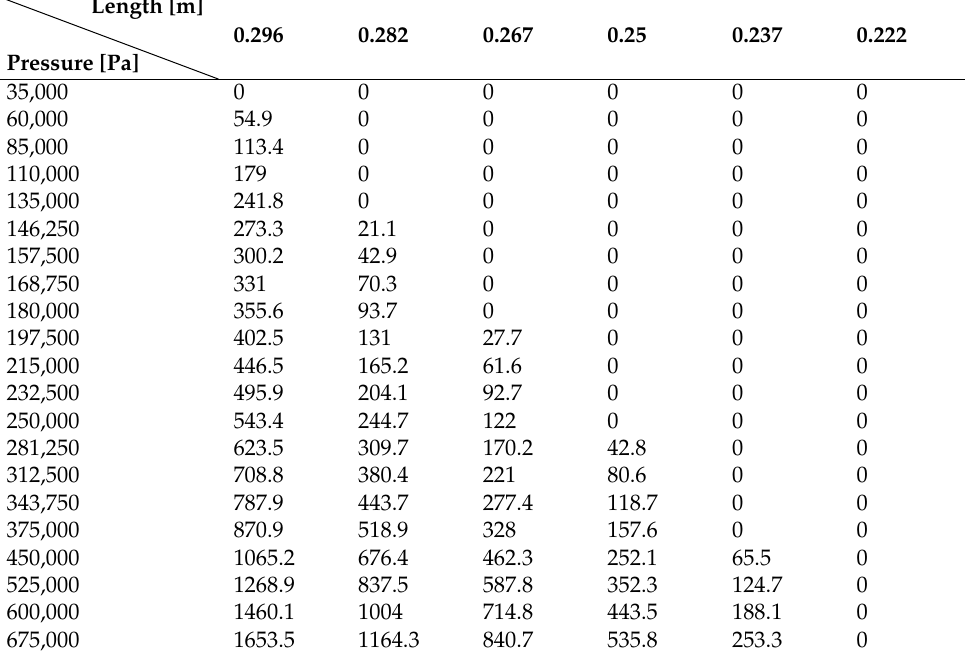
Table A1. Measured force map of a Festo DMSP-20-300 in [ N ]